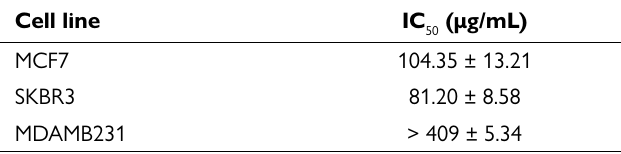
Table 1. Cytotoxicity of BthTX-I towards breast cancer cell lines.